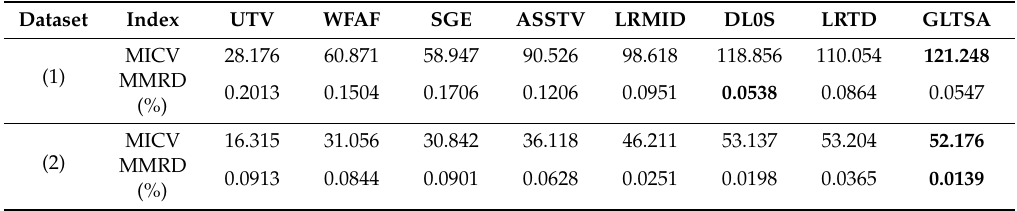
Table 3. The MICV and MMRD index results of the real data